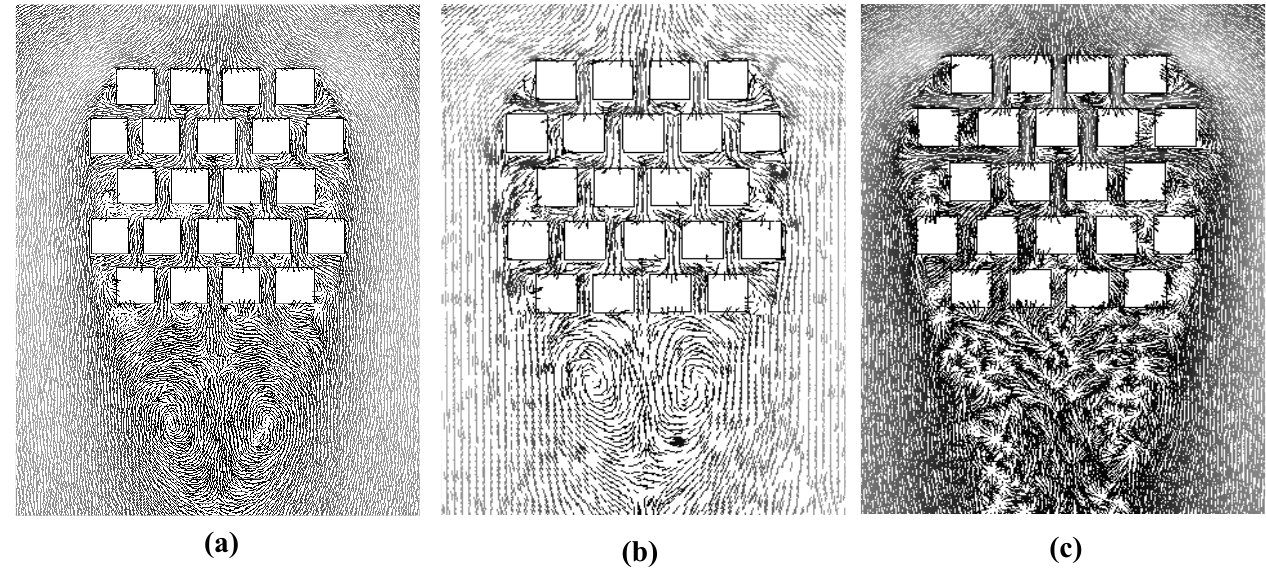
Fig. 8. Total pressure profiles according to type of mesh along X